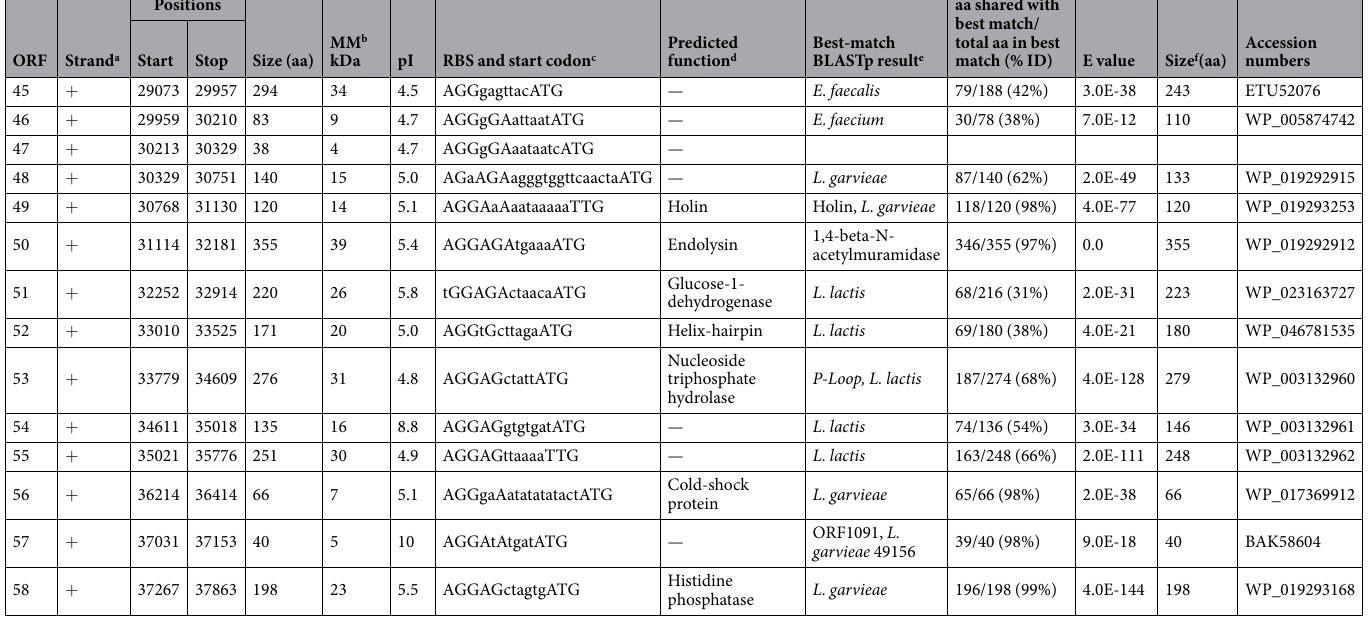
Table 1. ORFs deduced from the genome of the temperate bacteriophage PLg-TB25. a Orientation of the gene in the genome. b MM, molecular mass. c RBS, ribosomal binding site: uppercase letters represent the hypothetical RBS sequences, bold letters the starting codons. d Indicates no significant matches. e BLASTp result corresponds to second best alignment. f Total size of the aligned